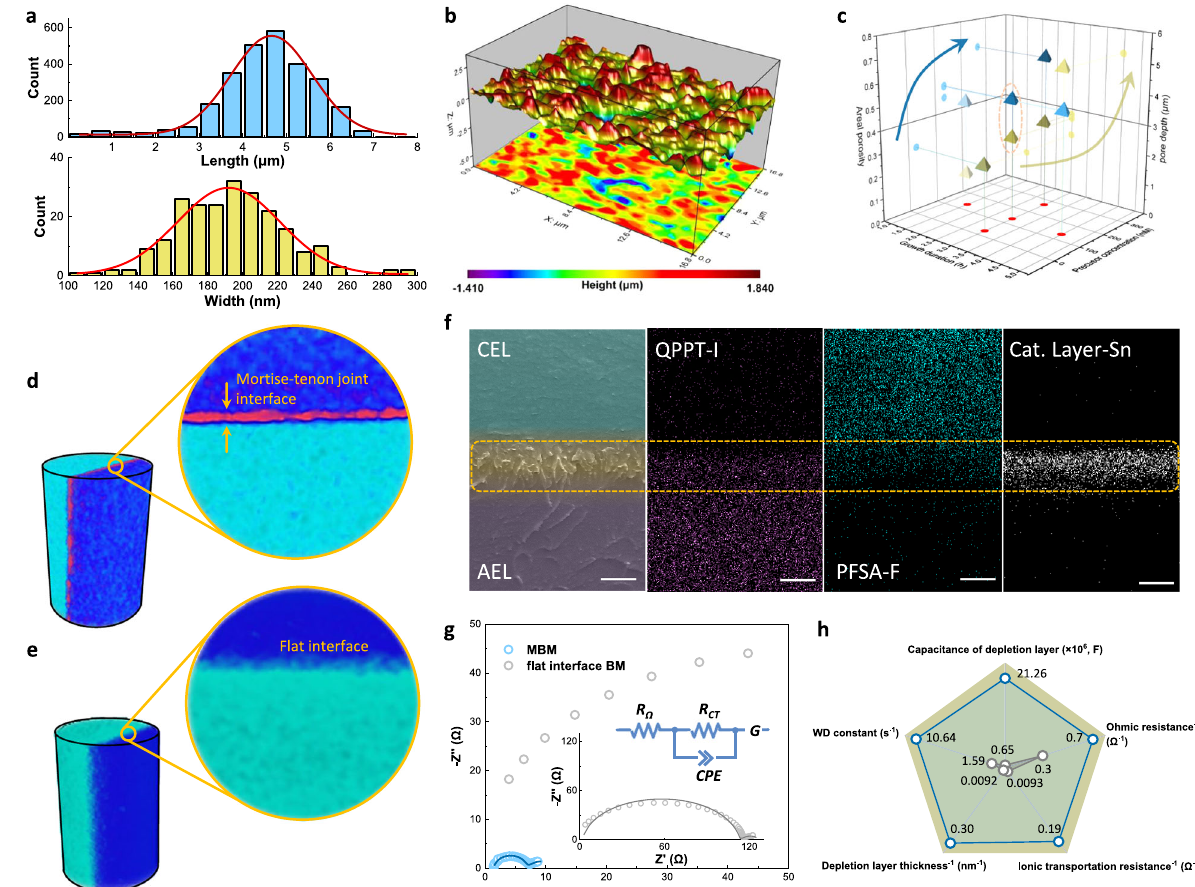
Fig. 3 | Regulation and characterization of MBM interlayer structure and determination of WD kinetics. a Distribution of heights (upper, wathet bar) and width (lower, yellow bar) of CoNi needle-like microarray as templates with their Gaussian pro fi les showing by red line plots. b Surface topography of template- transfer AEL re-plotted with lattice coordinates. c Independent regulations of AEL structural parameters on porosity and pore depth. Reconstruction of three- dimensional images and projection images of micro-computed tomography showing in d for MBM and e for fl at interface BM obtained by in-situ micro-CT tomography with scale bars of 5 μ m. f SEM image and elements distributions of